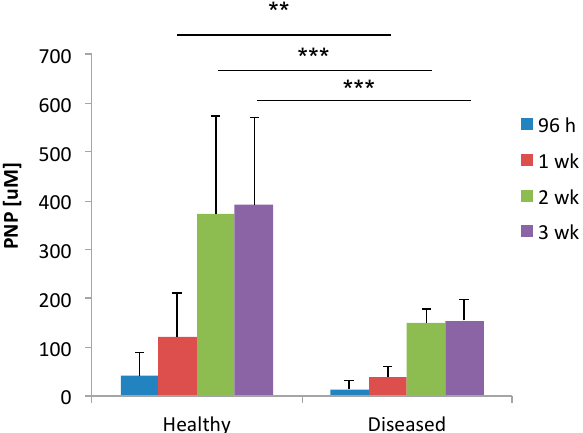
Figure 5. Alkaline phosphatase production in hGMSCs and dGMSCs. Cell number, assessed by MTS assay, was used to normalize the colorimetric signal prior to analysis. Assays were done at 72 h, 1 week, 2 weeks, or 3 weeks. In both groups, levels of ALP increased over time. There was significantly less ALP in the dGMSCs compared to that of the hGMSCs at 1 week, 2 weeks, and 3 weeks. ( t -test, two-tailed p -values: ** <0.01, *** <0.001).